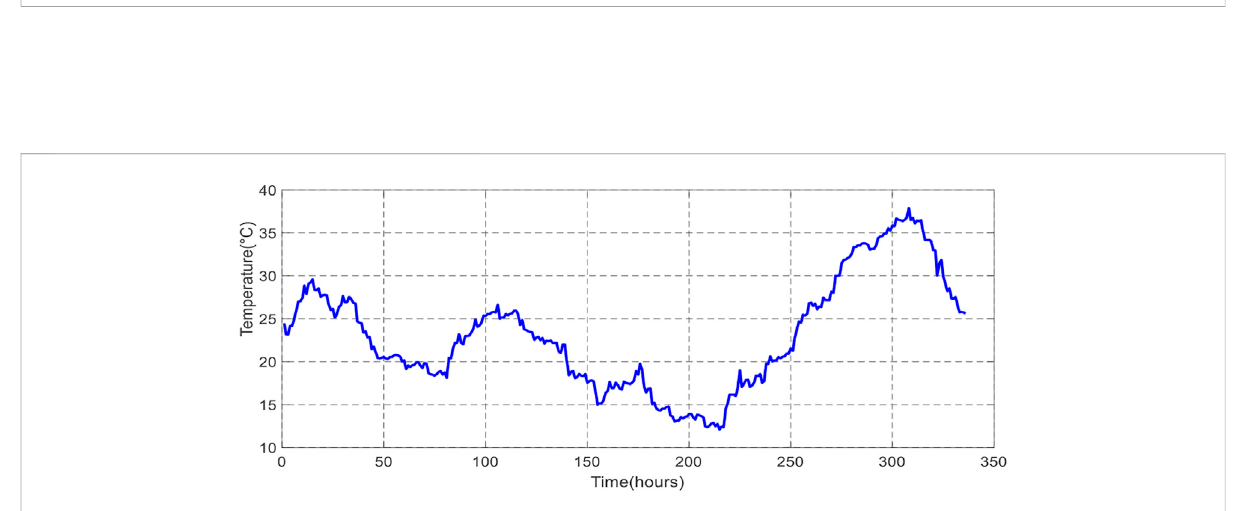
FIGURE 14 Temperature (7 days).